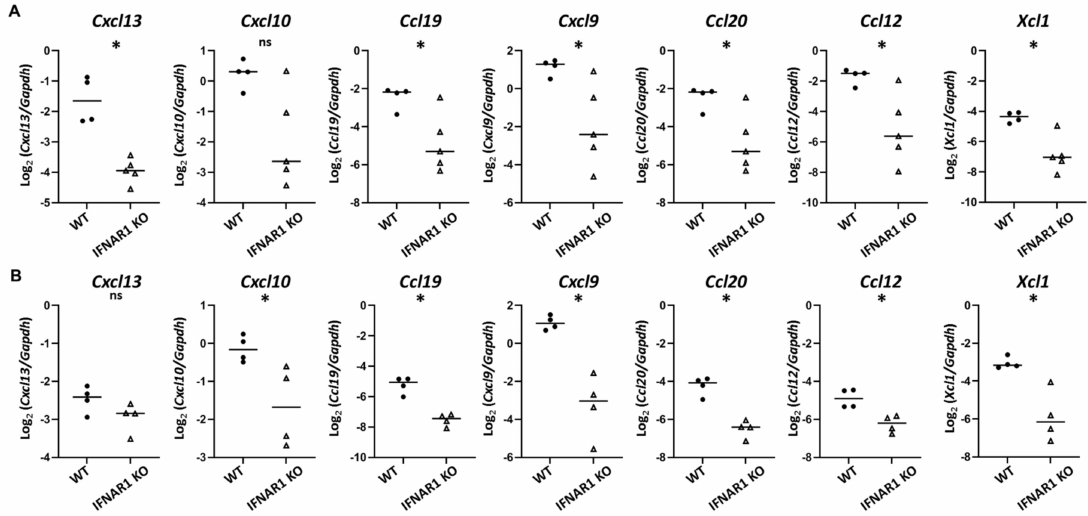
Figure 4. Identification of type I IFN-dependent chemokines upregulated in lacrimal glands of young NOD mice. ( A , B ) Graphs depict gene expression of indicated genes by qPCR from lacrimal glands of 14-week-old ( A ) or 8-week-old ( B ) WT or IFNAR1 KO NOD mice ( n = 4-5 mice per group). Symbols represent individual mice, lines are medians. p -values by Mann-Whitney test with * p < 0.05, ns p >